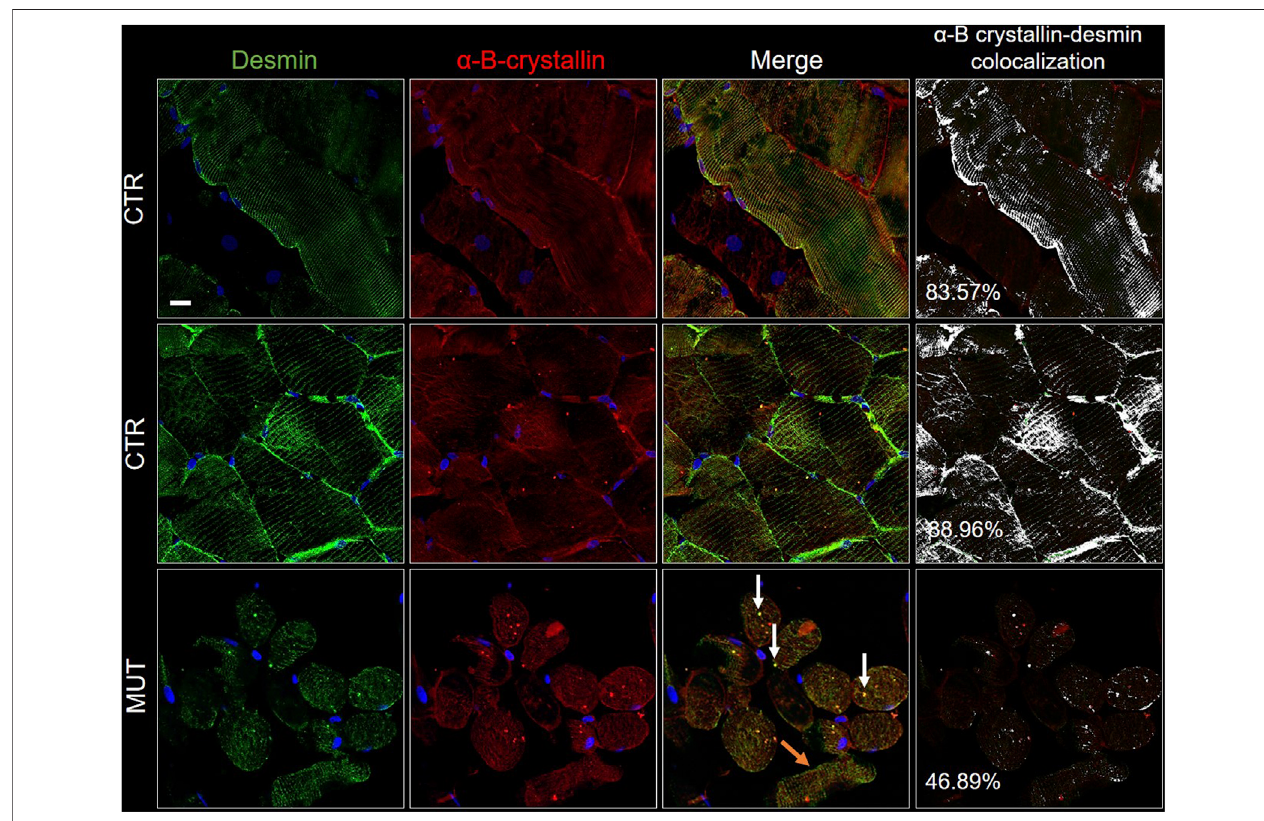
FIGURE 8 | Double immuno fl uorescence with FITC-conjugated antibody for desmin (green) and with TRITC conjugated anti-alpha-B-crystallin antibody (red) in CTR and MUT muscles. Alpha-B-crystallin positivity in the sarcolemma and sarcoplasm of CTR muscle fi bers appeared in the longitudinal (top row of CTR panels) and the transversal sections (middle row of CTR panels); this positivity was weaker in the MUT muscle fi bers (bottom row, MUT panels). Fiber disorganization was evident (orange arrows on the MUT panel to the right, one before the last or “ merge ” panel). On this same “ merge ” panel, white arrows point to examples of alpha-B- crystallin and desmin aggregates. Alpha-B-crystallin and desmin colocalization was higher in CTR muscle (longitudinal section, 83.57%; transversal section, 88.96%) than in MUT muscle (for example, only 46.89% in MUT muscle transversal section, as show in this fi gure). Nuclei were stained with probe Hoechst 33342 (blue). Bar = 25